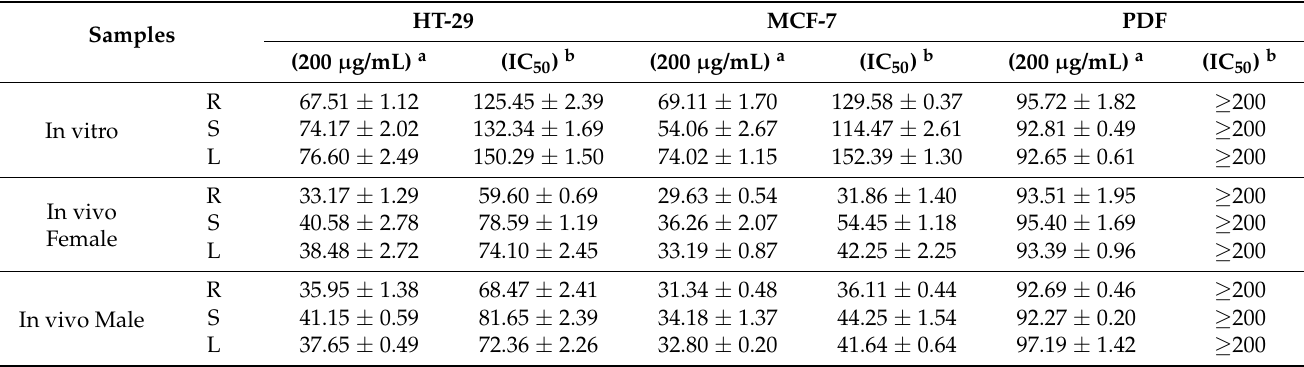
Table 1. Toxic and cytotoxic activity results of in vivo and in vitro samples of Pistacia khinjuk Stocks. a : viability (%) values at 200 µ g/mL concentration; b : The IC 50 is the concentration of extracts required for 50% inhibition, IC 50 values represent the means ± standard deviation meaning of three parallel measurements ( p <